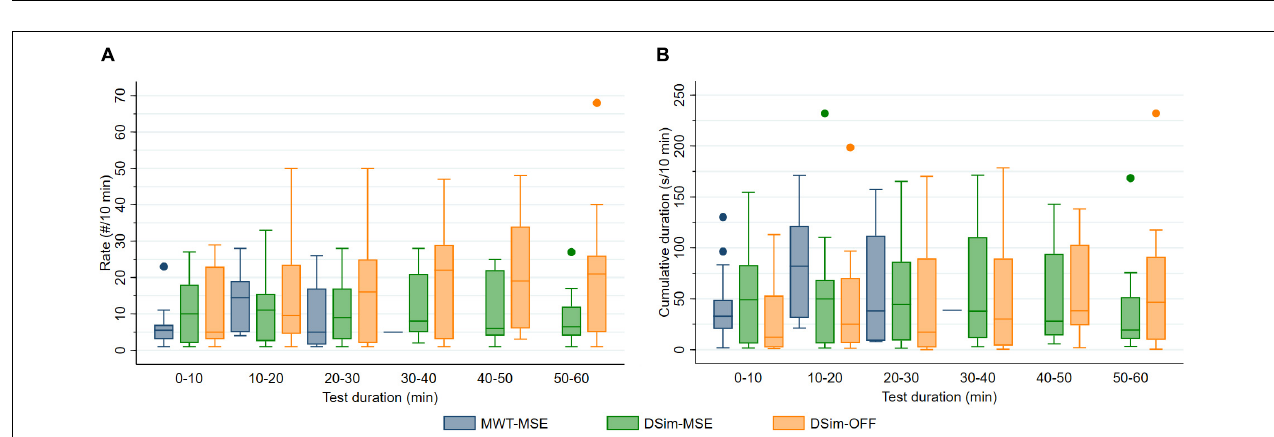
FIGURE 3 | Occurrence of microsleep episodes (MSEs, o) and latencies to the first off-road event (OFF, I) until sleep onset ( (cid:4) ), or if no sleep occurred the end of trial ( (cid:78) ), in (A) the maintenance of wakefulness test (MWT) and (B) the driving simulator after sleep deprivation. In case no MSE, sleep or OFF occurred, latencies were set to either sleep onset or the end of the test, whichever came first. Each horizontal line represents one of the 18 participants, ordered by the latency to sleep onset in the MWT. This participant numbering was also applied to the other figures.